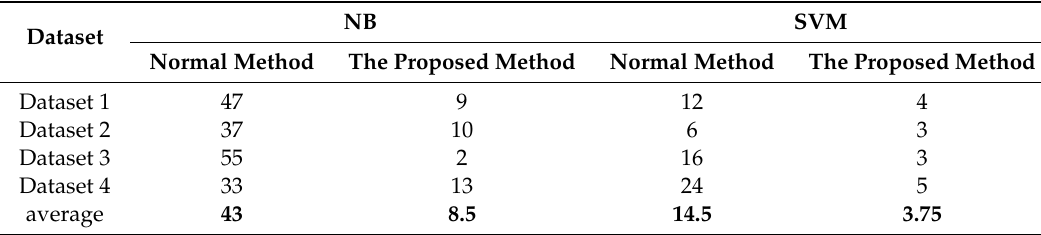
Table 3. Minimum number of spectral channels (MNSC) comparison of classification with echo maximum.